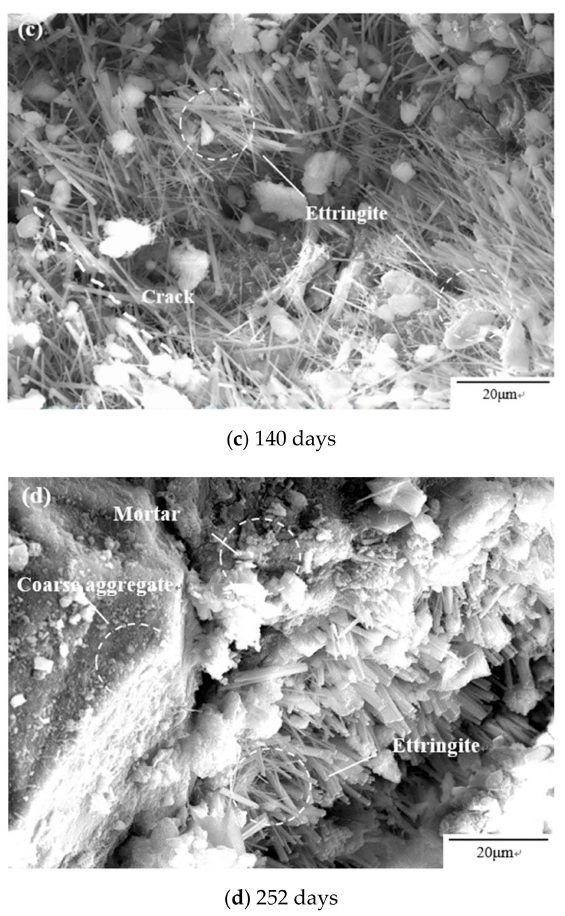
Figure 8. Microstructure of sample D5W1 exposed to sulfate solution under drying–wetting cycles. ( a ) 0 d; ( b ) 28 d; ( c ) 140 d; ( d ) 252